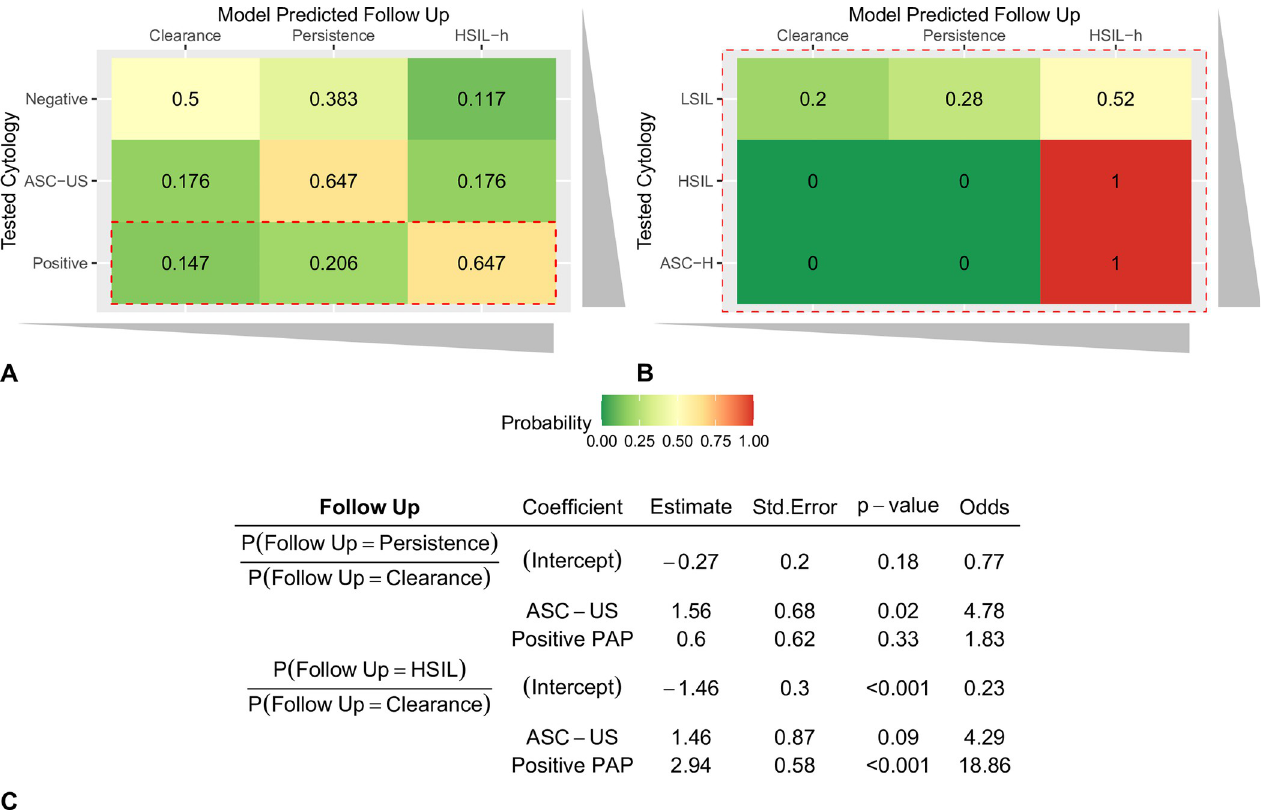
Fig 5. Multinomial logistic regression results for the five-year follow-up analysis of the 171 women with positive-Hybrid-2-Capture results. Interestingly, model predicted follow-up probability could be associated with a preponderant cytology test result. A) Negative, Atypical Squamous Cells of Undetermined Significance (ASC-US), or positive-cytology test results to predict associated follow-up class probability. These results support a direct association with prognosis, i.e., negative-cytology/clearance (P = 0.5), ASC-US/persistence (P = 0.647, 4.78 odds ratio), and positive-cytology/High-Grade Squamous Intraepithelial Lesion (HSIL) (P = 0.647, 19.09 = 18.86 + 0.23 odds ratio). B) Zoom-in for positive-cytology into Low-grade squamous intraepithelial lesion (LSIL), HSIL or Atypical squamous cells, which cannot exclude high-grade squamous intraepithelial lesion (ASC-H) results. It is worth noting that for more aggressive positive cytology, such as HSIL or ASC-H, the predicted follow-up has no discrepancy for histological-HSIL (P = 1). C) Multinomial logistic regression model parameters, where the clearance follow-up class has been chosen as reference to compare against persistence or HSIL cases.